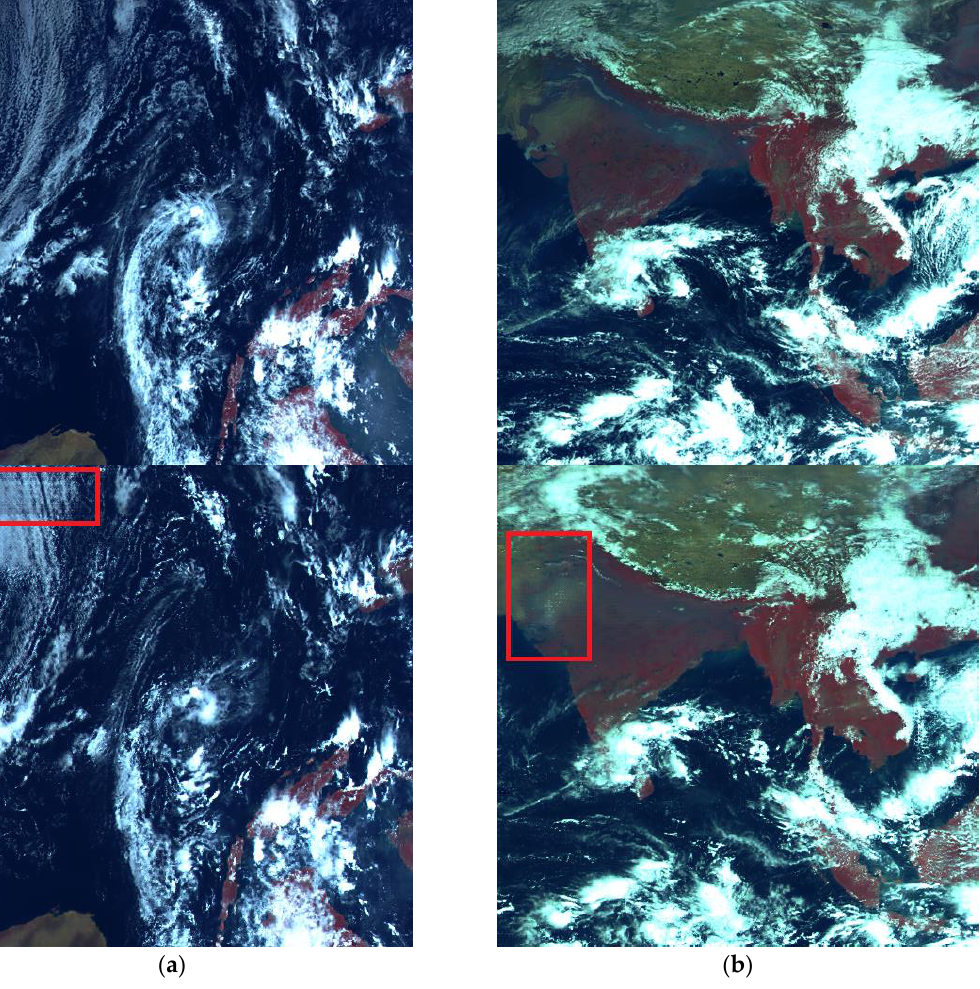
Figure 6. Example results of detail distortion on visible spectrum image. Subfigures ( a ) and subfigures ( b ) are two independent test